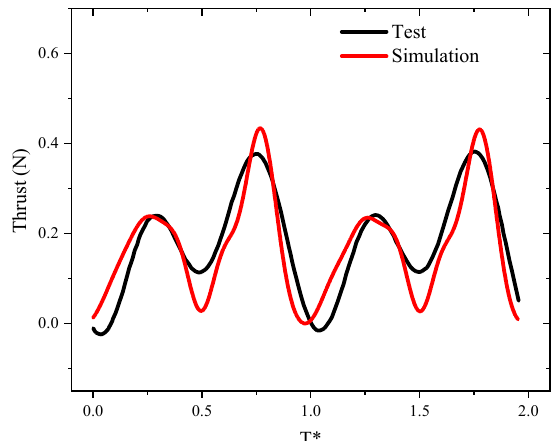
Figure 8. Periodic change curve of torsion angle in 0.71 span.